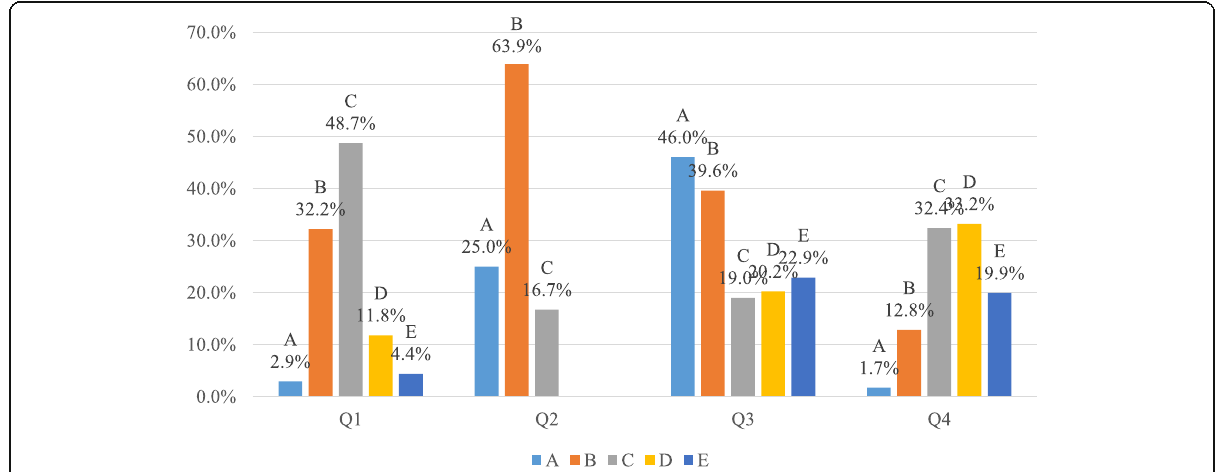
Fig. 1 Descriptive statistics of Q1--Q4. Note: Appendix 1 contains details of the questions and